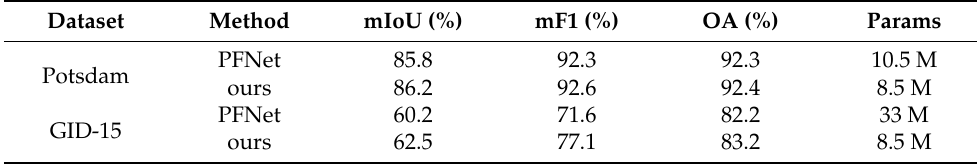
Table 1. Comparison of the main metrics with PFNet on the test set.